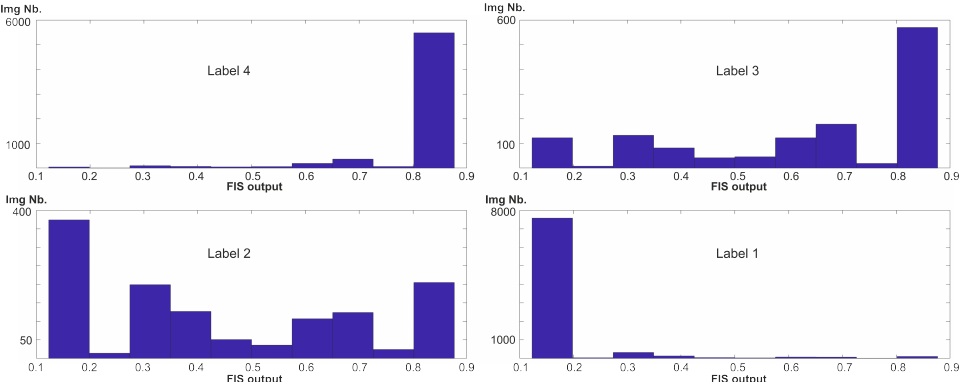
Figure 12. Histograms of FIS outputs obtained for the data, categorized according to the labels collected in Table